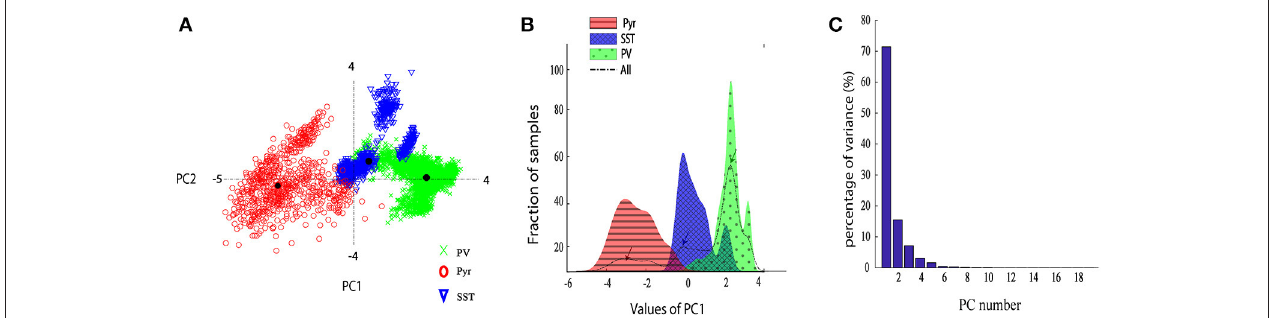
FIGURE 4 | Neurons discrimination based on PCA. (A) The scatter plot of the two PCs of the DCT of the spikes. Different groups are marked with different colors and marker. (B) The histogram of the first PC of the DCT coefficients. Overall the dashed black line shows sample distribution and different groups are marked with different colors; (C) The Percentage of variance captured by each PC, PCs 1–20.